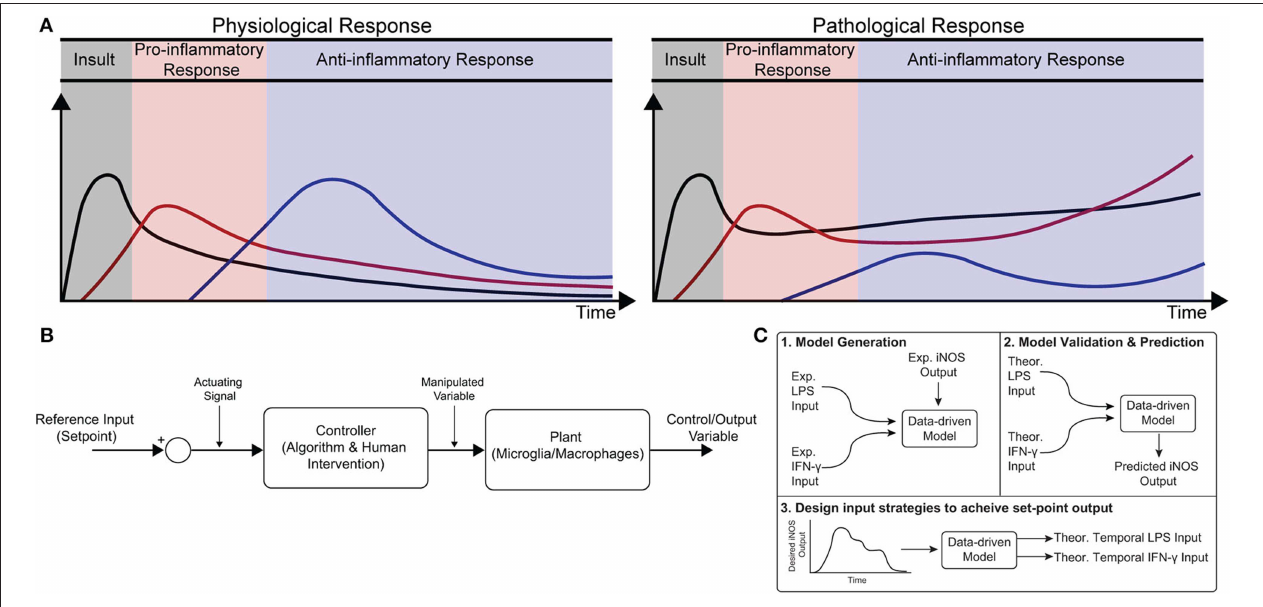
FIGURE 1 | Conceptual diagram of modeling immune response in health and disease. (A) Immune response as dynamically regulated in health (left) and dysfunctional in chronic conditions (right). (B) Block diagram with macrophages as the “system” or “plant” that is being controlled. (C) Identification, validation, and prediction of inflammatory response as a three-step process consisting of (1) design of an engineering model structure and fit of model parameters, (2) comparison of predicted and experimental results, and (3) use of the predictive model to design input strategies to obtain a desired